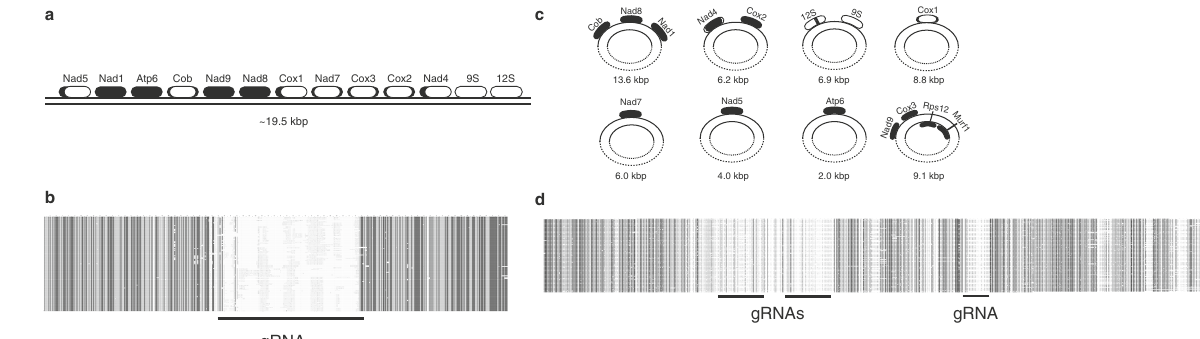
Figure 8. Hypotheses for the structure and content of A. spiralis and P. ankaliazontas mitochondrial DNA. (a) A. spiralis ‘maxicircle’ DNA is likely linear, and approximately 19.5 kbp. A single contiguous DNA sequence could not be assembled; this hypothesis is based on consideration of long contigs from each of A. spiralis clones PhF-5 and PhF-6, along with manual correction of sequences. (b) A. spiralis PhF-6 gRNA-encoding maxicircles, also linear, are typically ~ 600 bp in length, and consist of a highly conserved region, along with a single gRNA-encoding region. A subset of 100 contigs was selected for display. (c) P. ankaliazontas encodes mitochondrial proteins on several ‘ maxicircles’, most of which are circular-mapping. Each maxicircle has a conserved region. (d) P. ankaliazontas minicircles are also circular-mapping, are typically 1300–2200 bp, encode 2 gRNAs, and contain a conserved region. A subset of 100 contigs were selected for display. Black shading in genes in ( a ) and ( c ) correspond to a gene region that is edited; white regions are unedited. The frequency of U indel editing is presented for each gene in Supplementary Material, Table S2. Shading in ( b ) and ( d ) correspond to sequence identify of ≥ 90%, corresponding to minicircle backbone sequence, whereas divergent are similar to mitochondrial mRNAs, suggesting a role in